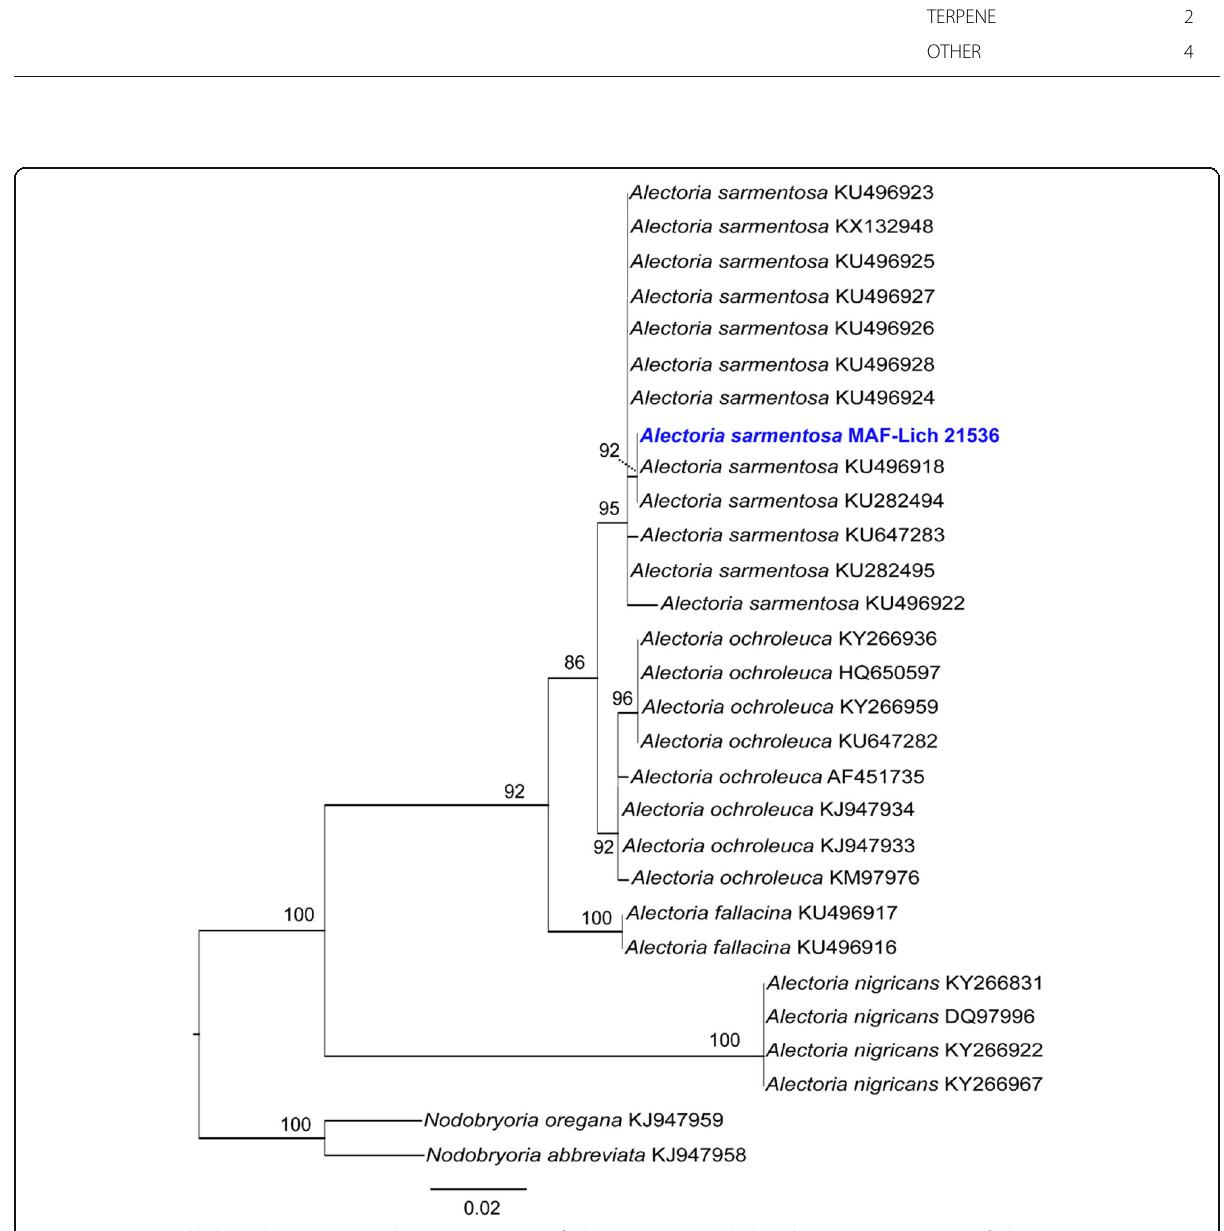
Fig. 4 A maximum likelihood (ML) tree based on ITS sequences of Alectoria species including the genome sequence of Alectoria sarmentosa reported here. The ML tree obtained with RAxML is shown. The isolate from which the genome was sequenced is indicated in blue and bold. ML bootstrap values ≥ 75% are indicated at the branches. Two species of Nodobryoria were used as out-group (Divakar et al. 2015)